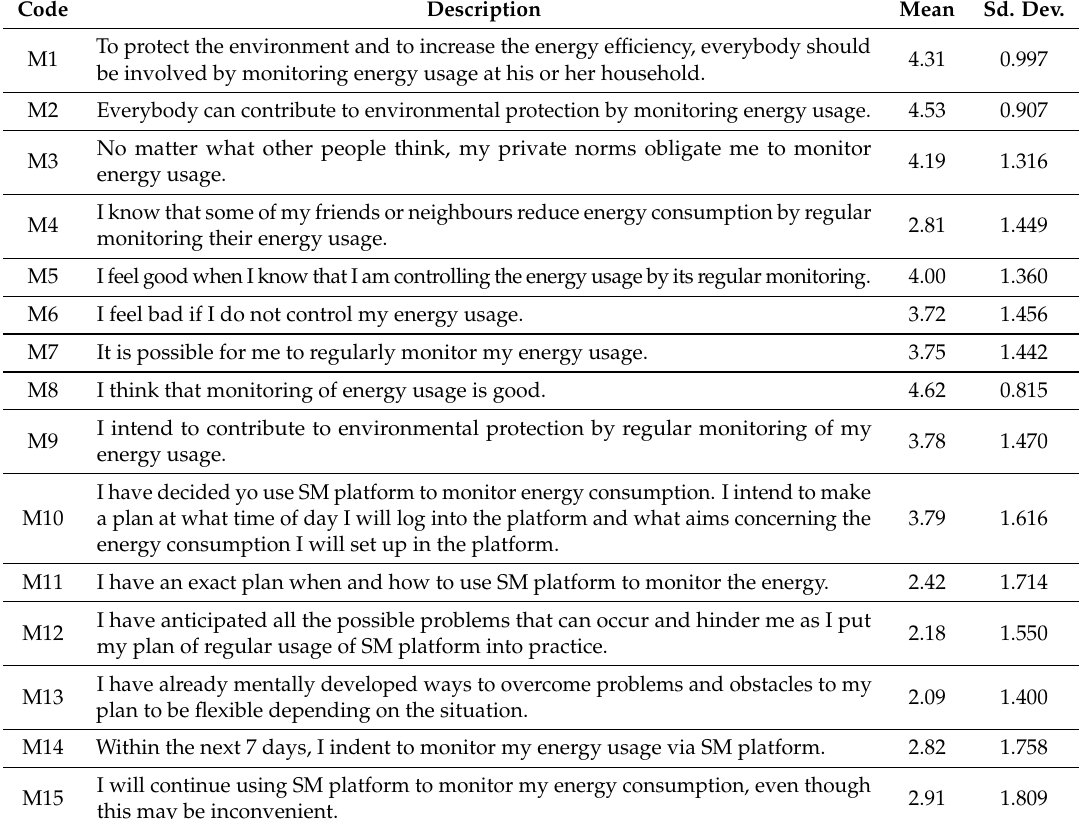
Table 3. Attitudes and behaviors towards monitoring of energy usage by means of